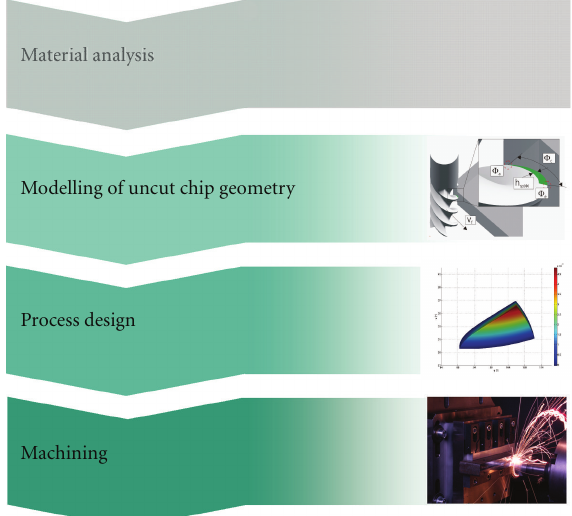
Figure 2: Approach for optimizing milling process design on base of modelling the uncut chip